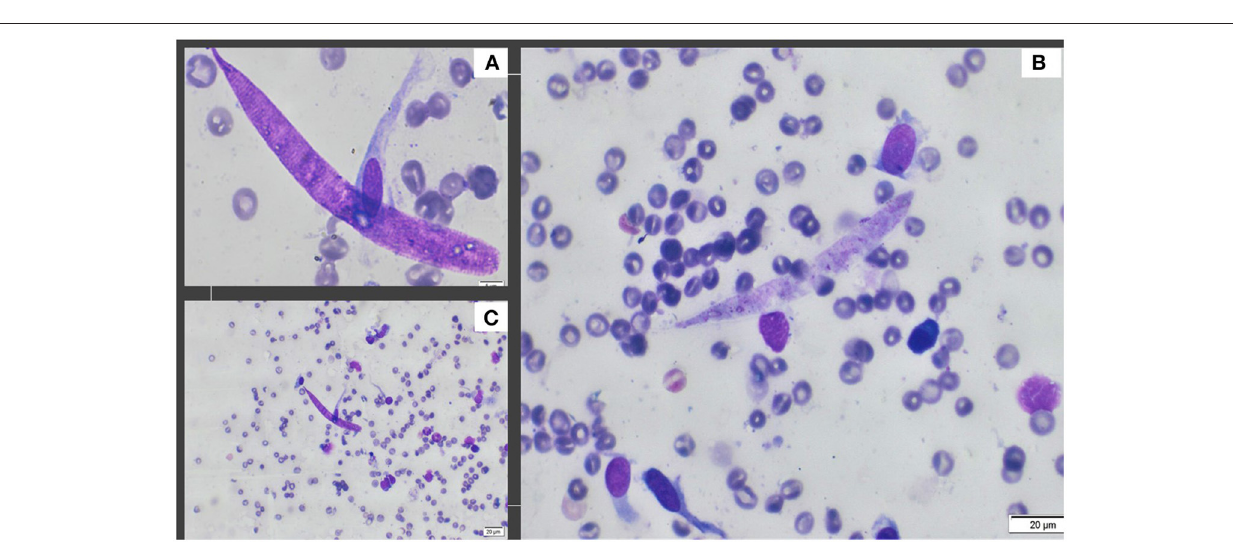
FIGURE 2 | Photographs obtained from cytology. (A) The detailed aspect of Onchocerca lupi larva obtained with 100X; (B) A typical larva and presence of fibroblasts, endothelial cells and plasma cells, 40X; (C) Presence of larva and plasma cells, eosinophils, fibroblasts and non-keratinized epithelial cells,